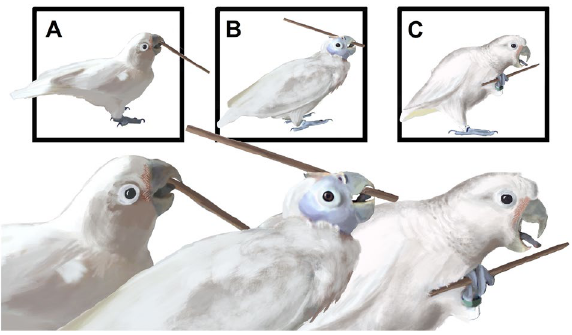
Figure 3. Distinctive techniques and use of the tongue during insertions for the 3 solvers: ( A ) Figaro, ( B ) Fini, and ( C ) Pipin. ( A ) Figaro used his tongue to hold the rear end of the stick towards the inner upper beak, a balance between the position of the tongue and the head allows for movements of the stick (mostly vertical); ( B ) Fini held the stick by the front end, after inserting a short portion of the stick with her head movement and used her tongue a to push the stick with repeated thrusts; ( C ) Pipin grabbed and began the insertion with a leg grip and used his tongue to guide the stick towards the goal. After completing the insertion his technique changed to a beak hold similar to ( A